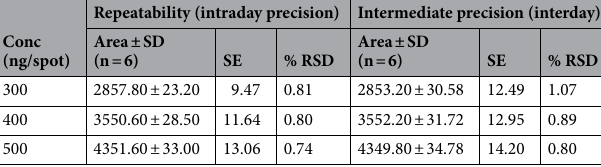
Table 3. Precision of the proposed method.